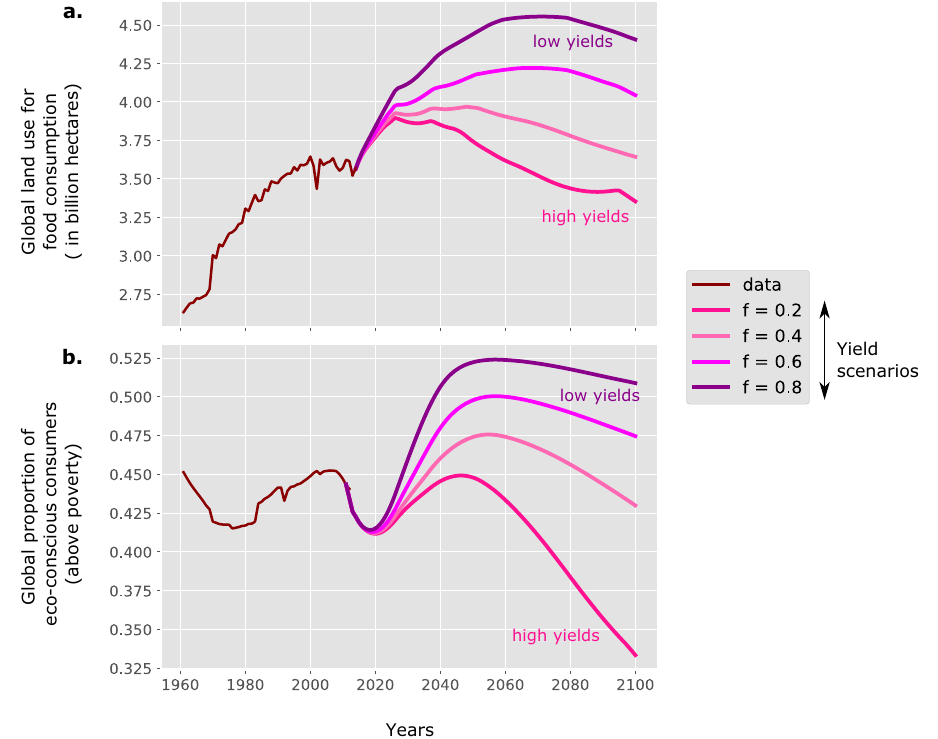
Fig. 2 Baseline global land use and global eco-conscious consumer proportion projections till 2100 under four yield scenarios and the population and income scenario of SSP2. Results are shown for yield scenarios ranging from high ( f = 0.2) to low ( f = 0.8) future yields at the SSP2 income and population scenario. The historical data for global land use due to food consumption and the corresponding global proportion of eco-conscious consumers (above poverty) are indicated with black lines in both the panels. The historical data is plotted from 1961 to 2013. See “ Methods ” and Supplementary Methods for more details on how these data are calculated. a Projections for global land use due to food consumption till 2100 under four yield scenarios at the income and population scenario of SSP2. b Projections for the corresponding global proportion of eco-conscious consumers till 2100 under the same four yield scenarios and the income and population scenario of SSP2. Compiled baseline projections for all the yield scenarios under all fi ve SSP scenarios (a total of 20 combinations) can be found in Supplementary Fig.